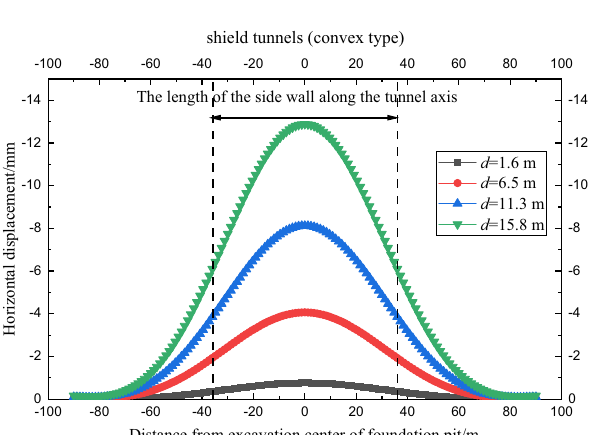
shield tunnels (convex type)